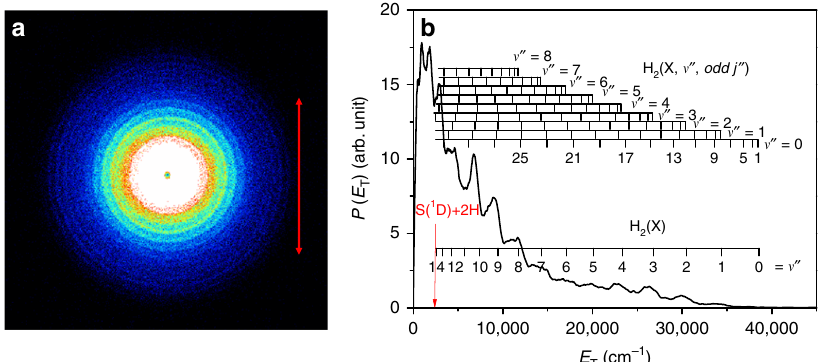
Fig. 2 Velocity map imaging and translational energy spectrum from H 2 S photodissociation. a Time-sliced velocity map image of the S( 1 D 2 ) photofragments from photolysis of H 2 S at λ = 139.11 nm with the polarization vector of the photolysis laser radiation ( ε phot , shown by the doubled headed red arrow) aligned in the plane of the image. b P ( E T ) spectrum derived therefrom assuming recoil from an H 2 co-fragment. The superposed combs indicate the H 2 ( v ″ , J ″ ) states responsible for the evident structure with, for simplicity, only the ortho - (odd) J ″ states indicated. The red arrow indicates the maximum E T values associated with the S( 1 D) + 2H channel. Source data are provided as a Source Data fi